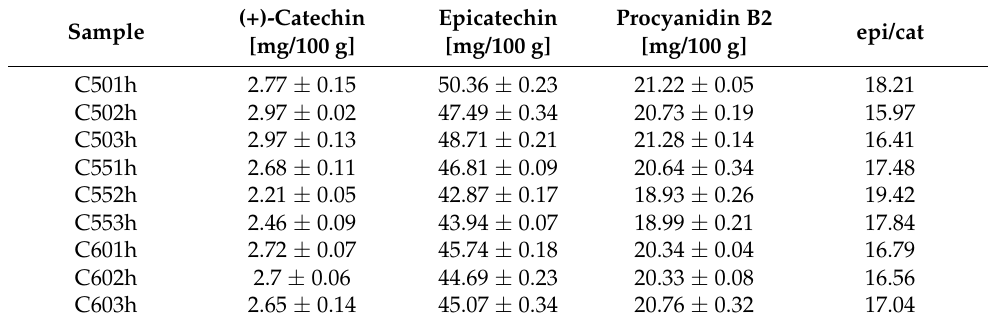
Table 1. Content of (+)-catechins, epicatechins and procyanidins B2 in CMM (the abbreviations used in the graph are described in Section